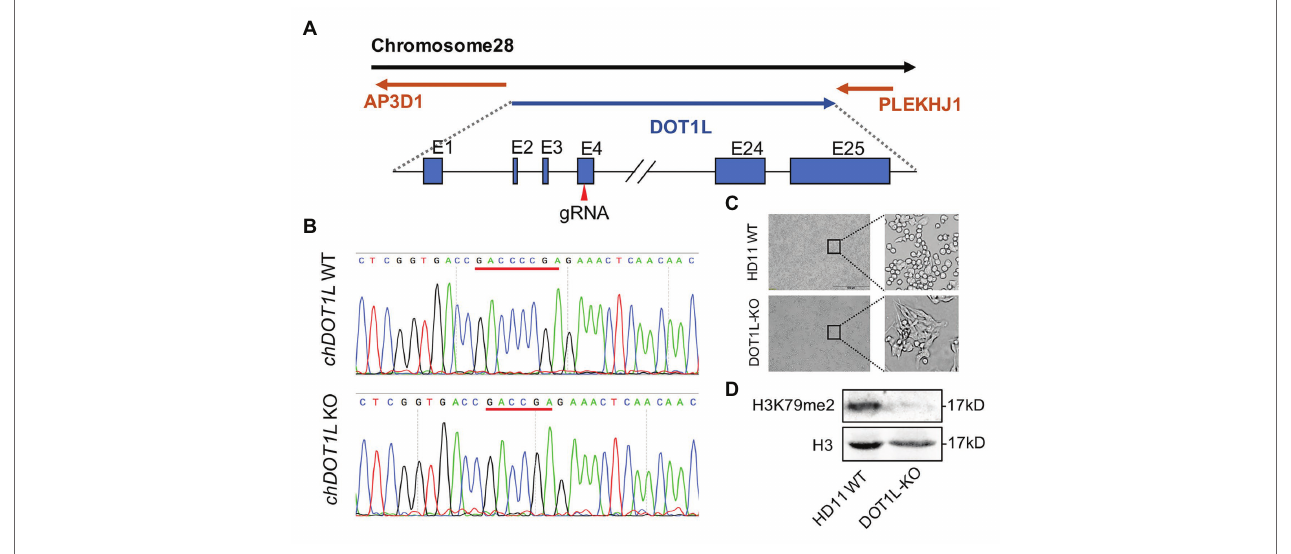
FIGURE 3 | Generation and identification of DOT1L-knockout HD11 cell line. (A) The genomic architecture of chicken DOT1L gene and the CRISPR/cas9 strategy for DOT1L knockout. (B) DNA sequencing results of the chicken DOT1L allele between the wild-type (WT) and the DOT1L knockout cells clone (C) HD11 morphology after DOT1L depletion. Scale bar, 500 μ m. (D) Western blot detected the levels of DOT1L mediated-H3K79me2 in DOT1L-KO cells and WT cells.